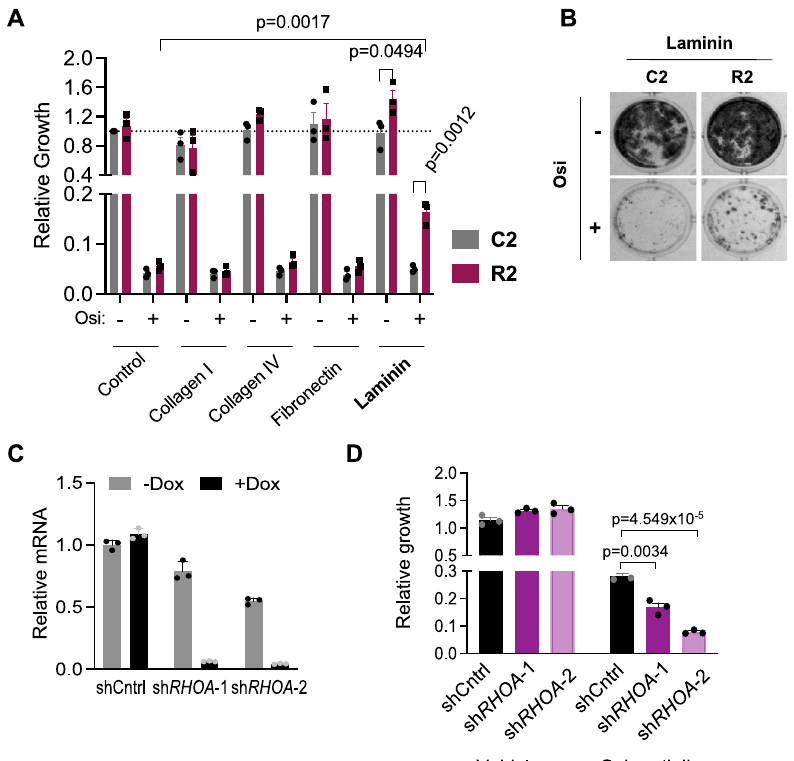
Fig. 6 | Laminin and RhoA promote the outgrowth of residual metastatic cells under osimertinib treatment in vitro. A C2 and R2 cells were cultured on stan- dardplates(Control)orplatescoatedwiththe indicatedECMproteins and treated withvehicleor160nMosimertinib.Relativetumorcelloutgrowthwasmeasuredby BLI 18 – 21 days after plating. All values are normalized to C2 vehicle-treated on controlplate. N =3biologicalreplicates.Dataispresentedasmeanvalues+/ − SEM. P -values calculated by t -test (two-sided). B Representative images of samples in A grown on laminin and stained with crystal violet. C R2 cells expressing doxycy- cline- (Dox-) inducible short hairpins RNAs (shRNAs) against a control sequence